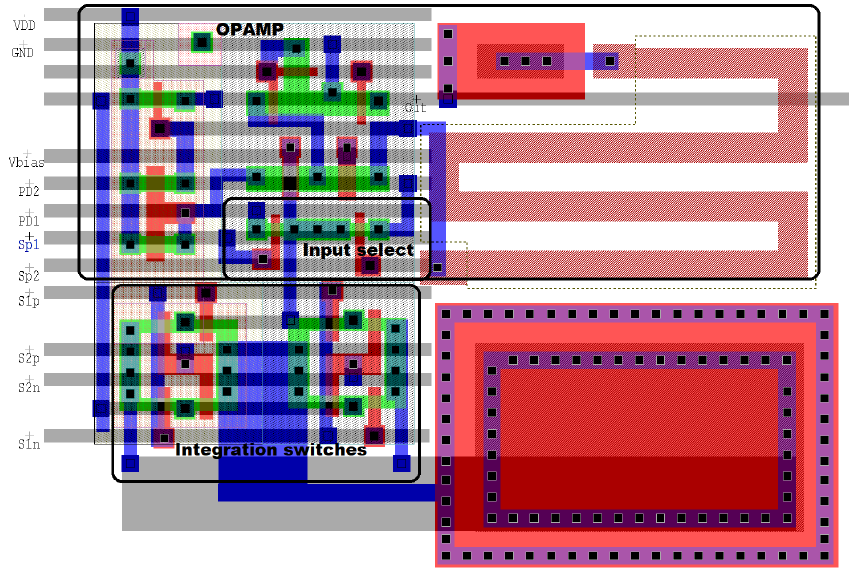
Figure 15. Layout of the smart pixel. We used the design shown in Figure 6, implemented on the TMSC 0.35 µ m mixed-signal process. The opamp and integration capacitors are implemented using two poly